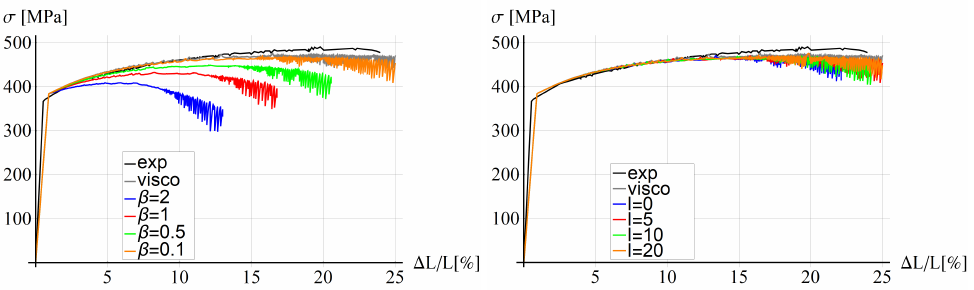
Figure 11. Stress vs. relative extension for different values of ductility and l = 5 mm ( left ) and for different internal lengths and β = 0.1 ( right